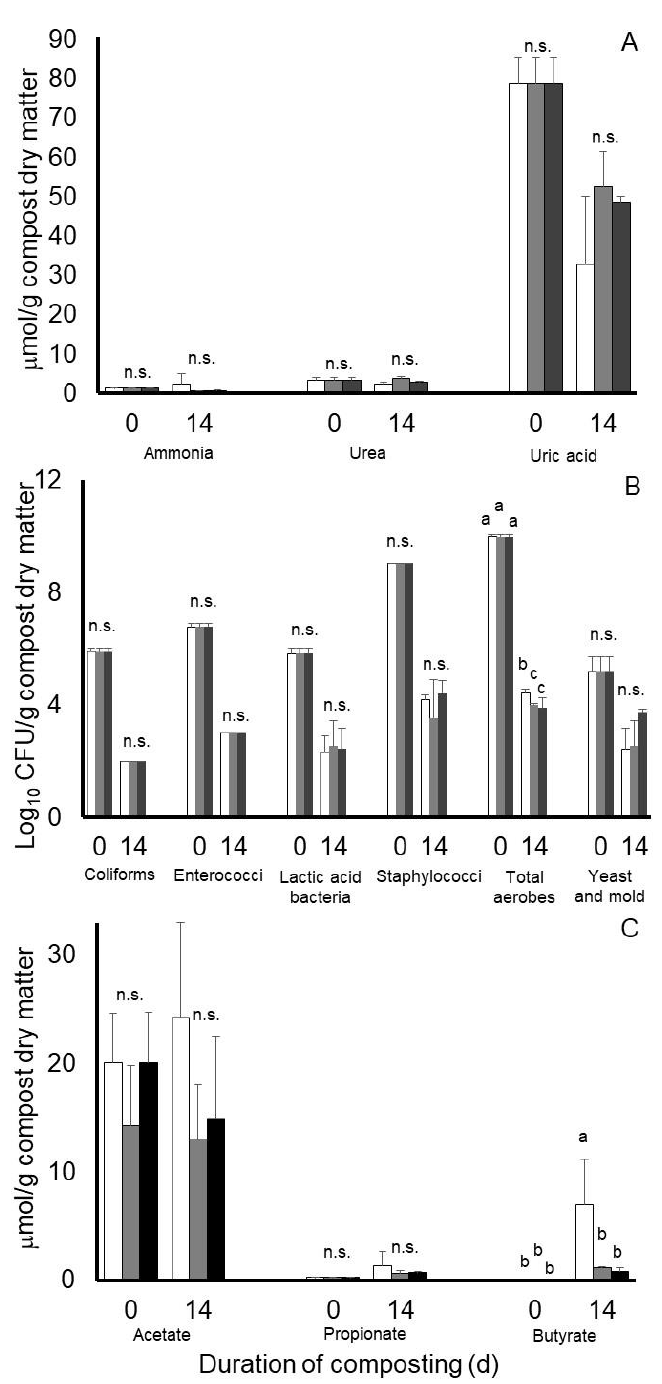
Figure 4. Least squares means of potential treatment by day of compost interactions for nitrogen ( A ), microbiological ( B ), and predominant volatile fatty acid accumulations ( C ) during 14 days of simulated composting of wood chip poultry litter treated without (open bars) or with 0.7% Chinook (gray bars) or Galena (black bars) hops in Experiment 2. Error bars reflect standard deviations from n = 3 replicated composts of each treatment and sample time. Means with unlike lowercase letters differ ( p < 0.05) based on a LSD all-pairwise comparisons test; means not differing significantly are denoted by n.s.